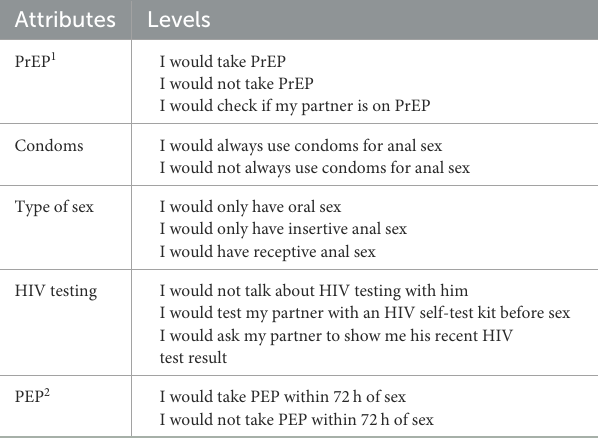
TABLE 1 Attributes and levels of the discrete choice experiment.